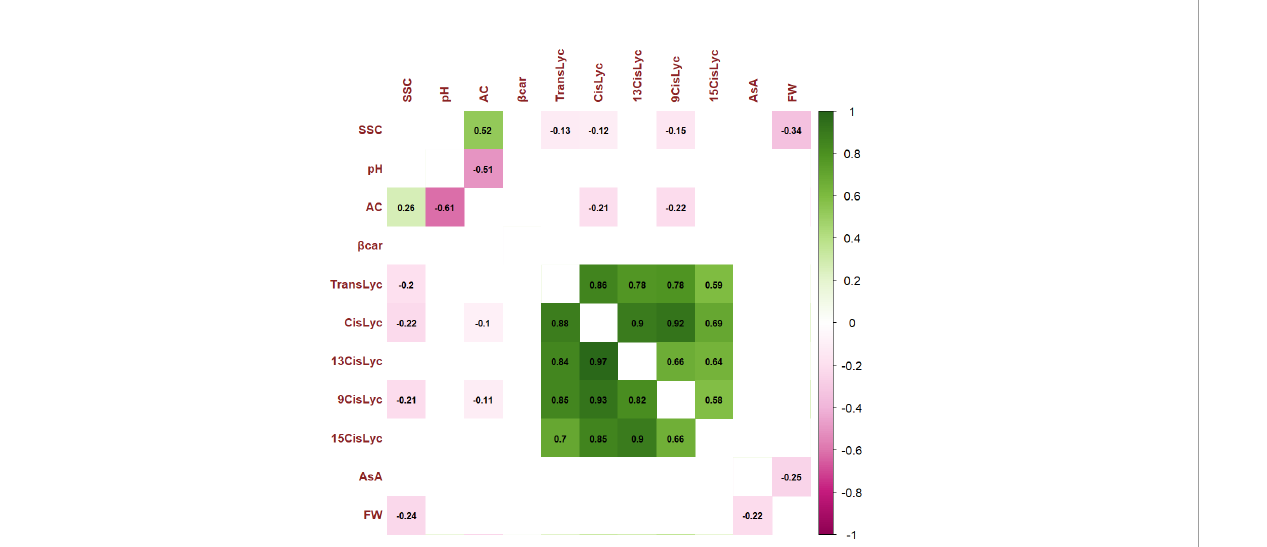
FIGURE 5 Pearson ’ s rank correlation coef fi cients between pairs of phenotypes. Correlation coef fi cients are indicated in each cell. Colored correlations are those with a P -value<0.05. Color intensity is directly proportional to the coef fi cients. On the right side of the correlogram, the legend color shows the correlation coef fi cients and the corresponding colors. The correlogram for traits scored during Y1 is placed below the diagonal, and the correlogram for traits scored during Y2 is placed above the diagonal. Trait acronyms are listed in Table